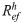
Estimation of Model FD in Period 4 (October/2008—September/2012).(a) observed incidence (O) and adjusted i (E), (b) m3/m, (c) Refh (h) and Refm (m), and (d) Ref=Refh×Refm.